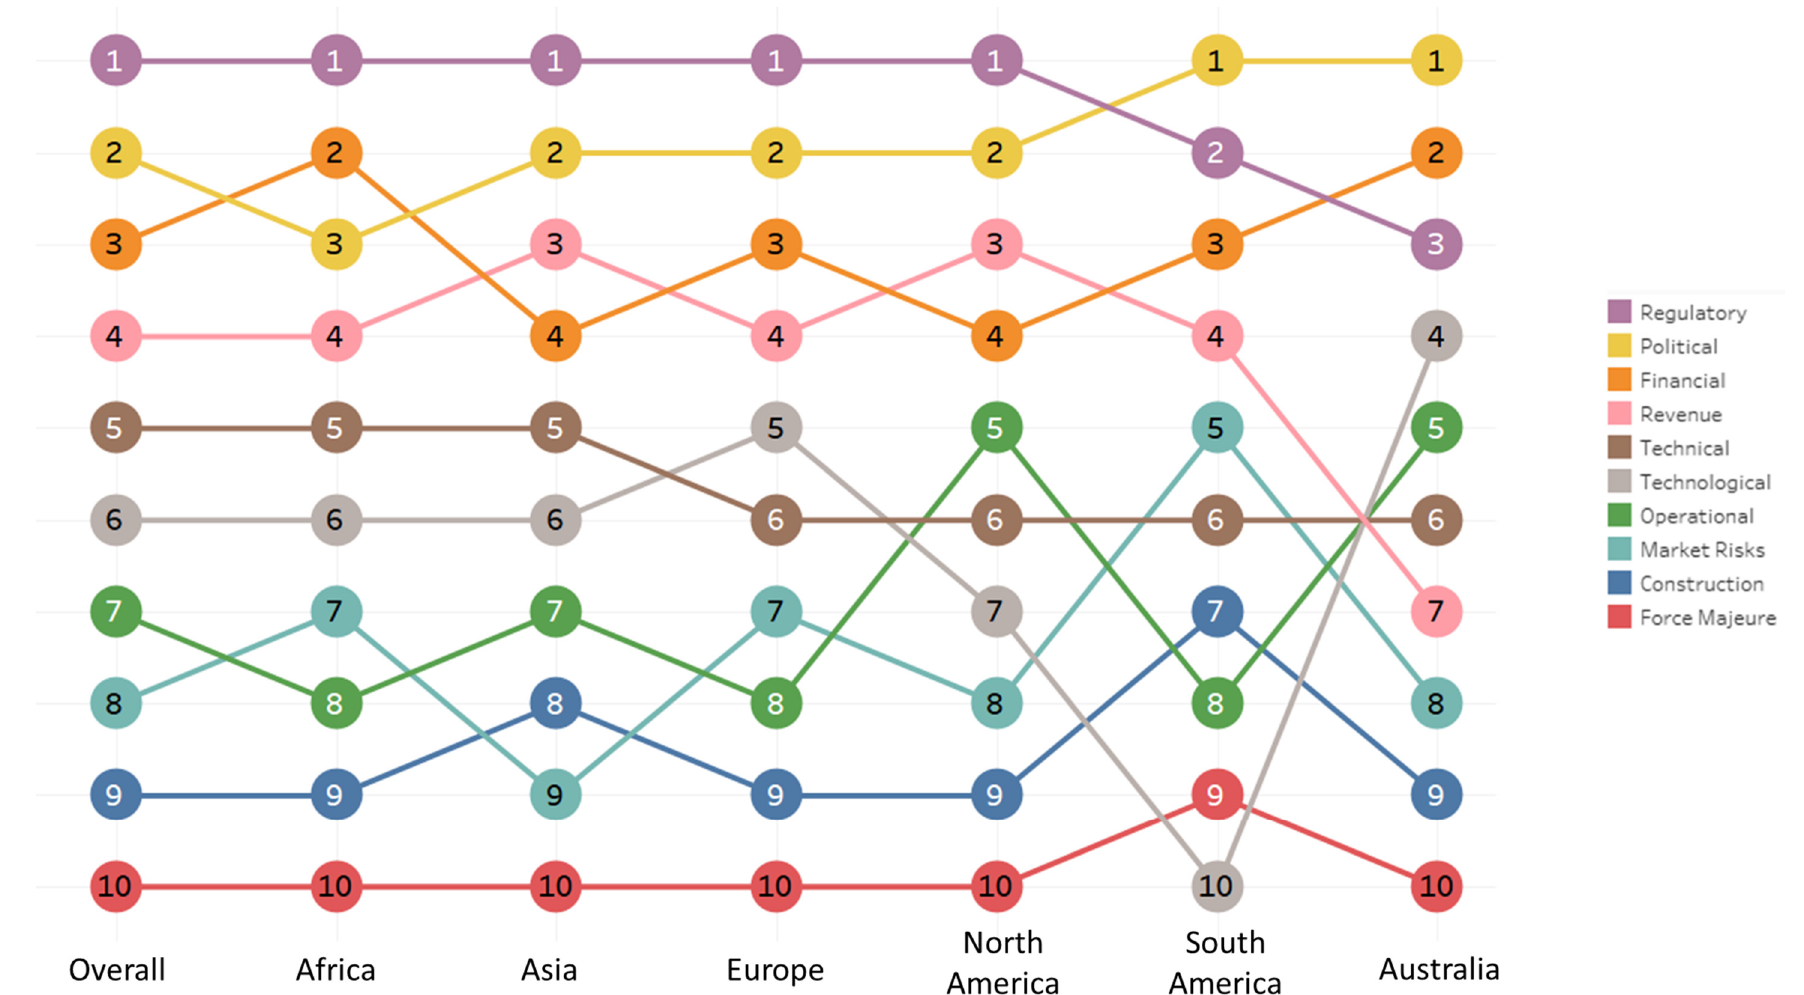
Figure 5. Rank of the different barriers on every continent according to the risk-severity value.